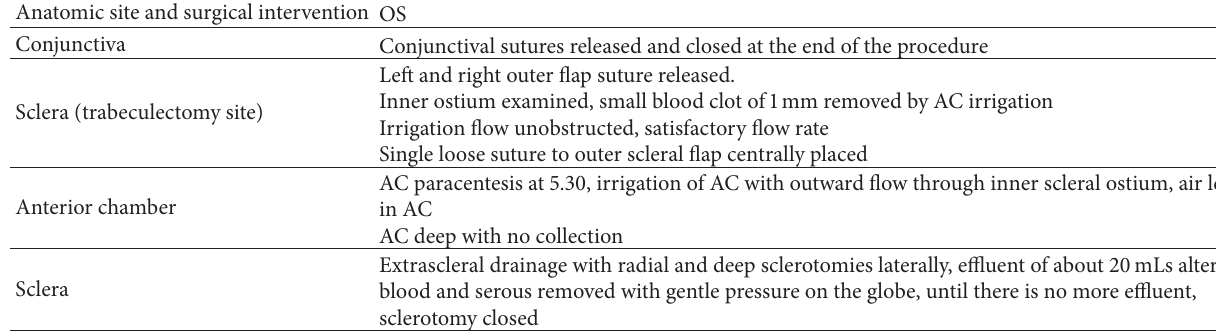
Table 4: Surgical intervention to the left eye.